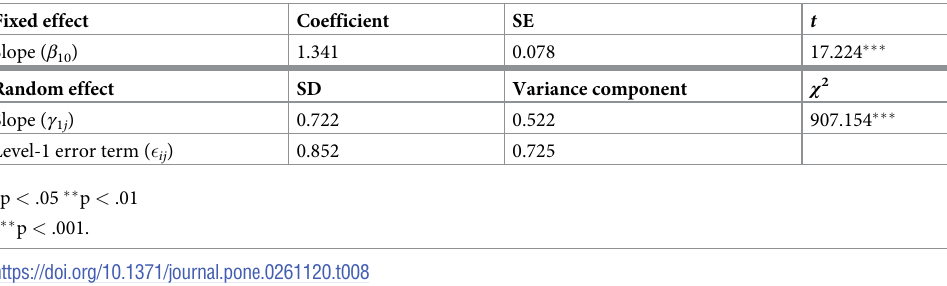
Table 8. Results from the unconditional